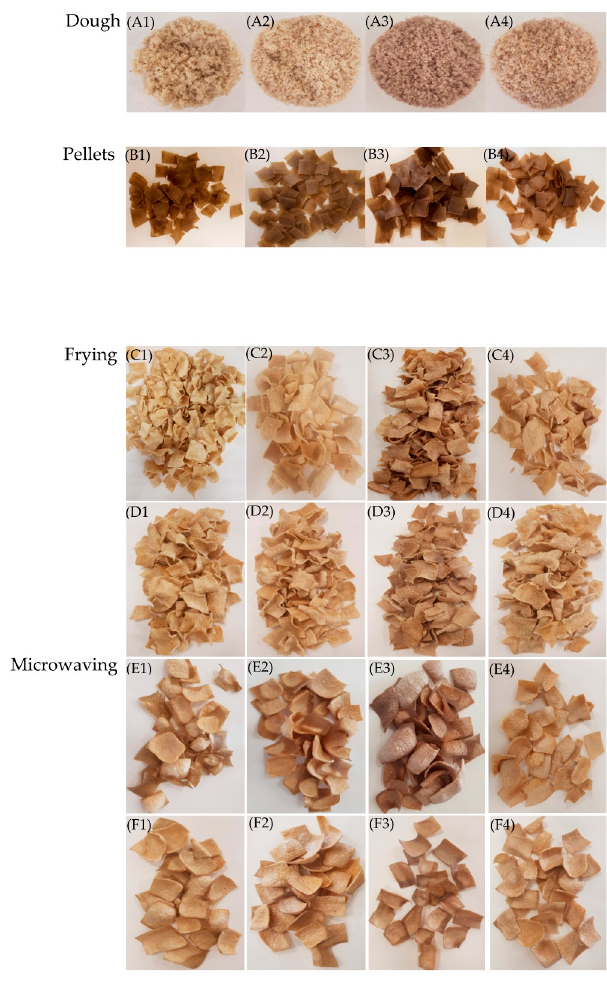
Figure 1. Processing of the obtainment of Jerusalem artichoke snacks. ( A )—dough: ( A1 )—no fruit powder addition, ( A2 )—cranberry powder addition, ( A3 )—chokeberry powder addition, ( A4 )—blackcurrant powder addition; ( B )—pellets: ( B1 )—no fruit powder addition, ( B2 )—cranberry powder addition, ( B3 )—chokeberry powder addition, ( B4 )—blackcurrant powder addition; Frying: ( C )—0 days of storage and ( D )—5 weeks of storage, ( C1 , D1 )—no fruit powder addition, ( C2 , D2 )—cranberry powder addition, ( C3 , D3 )—chokeberry powder addition, ( C4 , D4